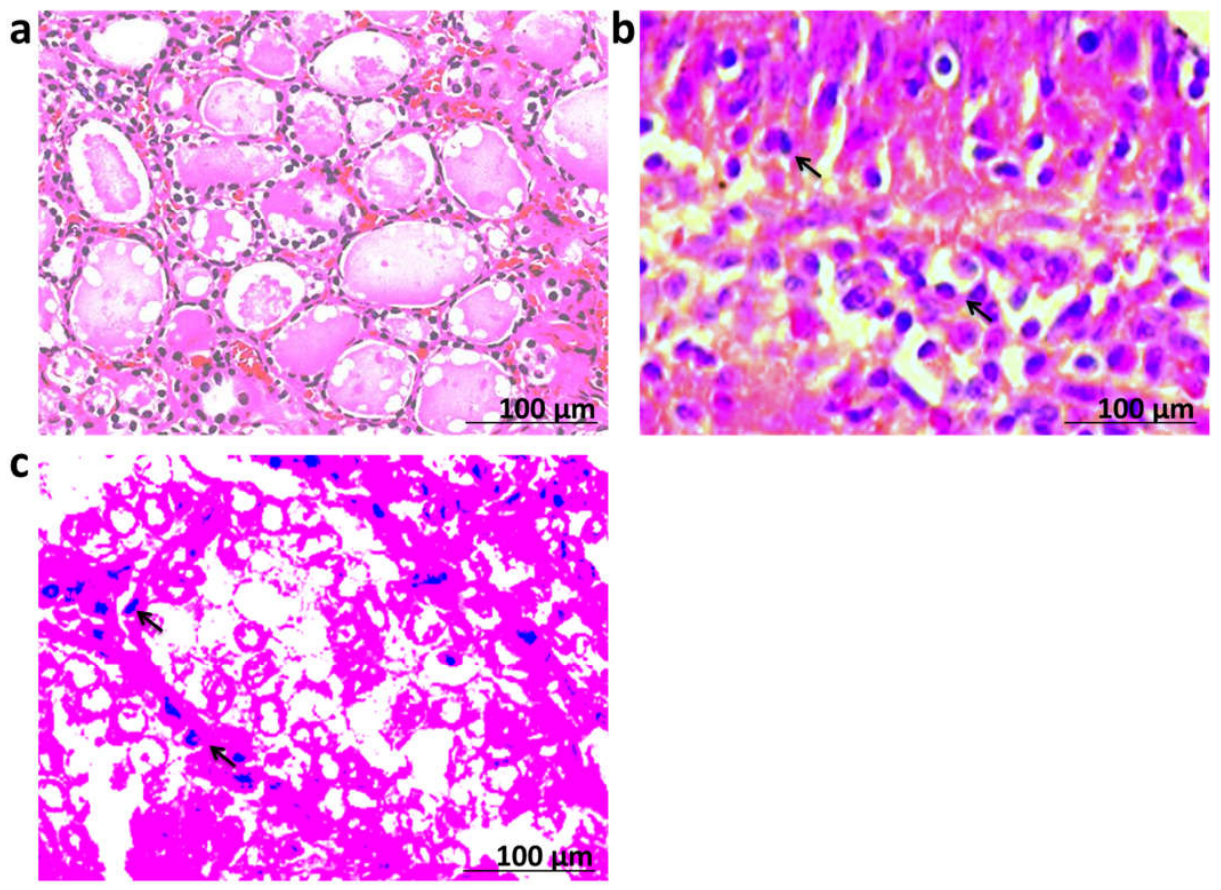
Figure 4. Histopathological changes in thyroid tissues; ( a ) control group showing normal architecture of thyroid cells. ( b ) Stage I group showing histopathological changes and heterogeneous in the thyroid cells (arrow). ( c ) Stage II group showing typical cytologic features and changes in nuclear features as nuclear size and shape and nuclear membrane irregularity (arrow). Slides were examined using H&E stain with magnification X40 and scale bar = 100 µm.